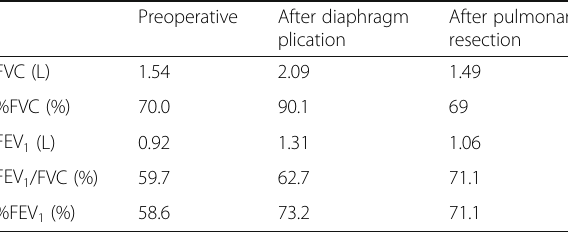
Table 1 Change in pulmonary function Preoperative